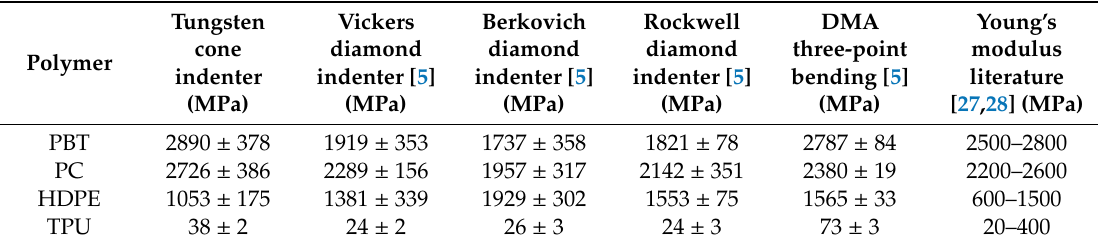
Table 4. Complex moduli for investigated polymers obtained with various indenters, three-point bending, and Young’s moduli from literature